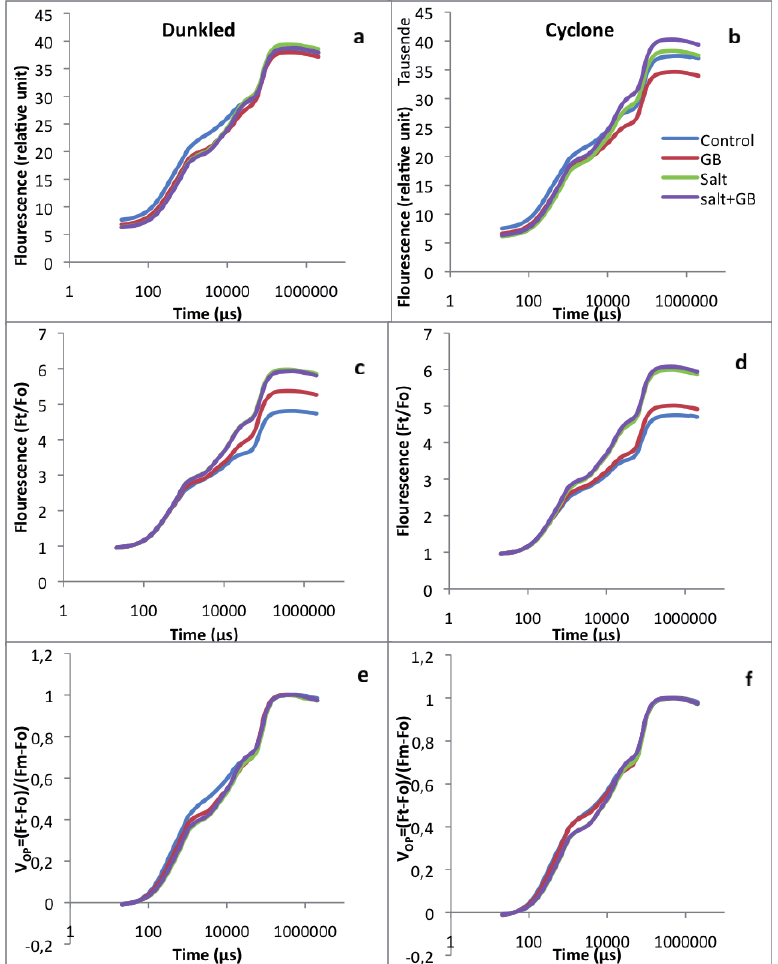
Fig. 3: Chlorophyll flourescence with and without normalization of two cultivars of canola ( Brassica napus L.) when three week old plants were subjected to foliar application of glycinebetaine and salt stress for further two